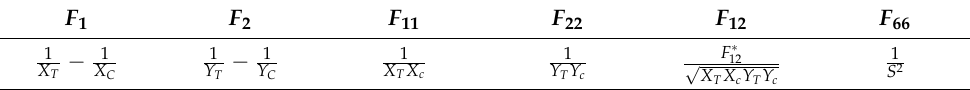
Table 5. Equations for calculating the coefficients for the Tsai–Wu